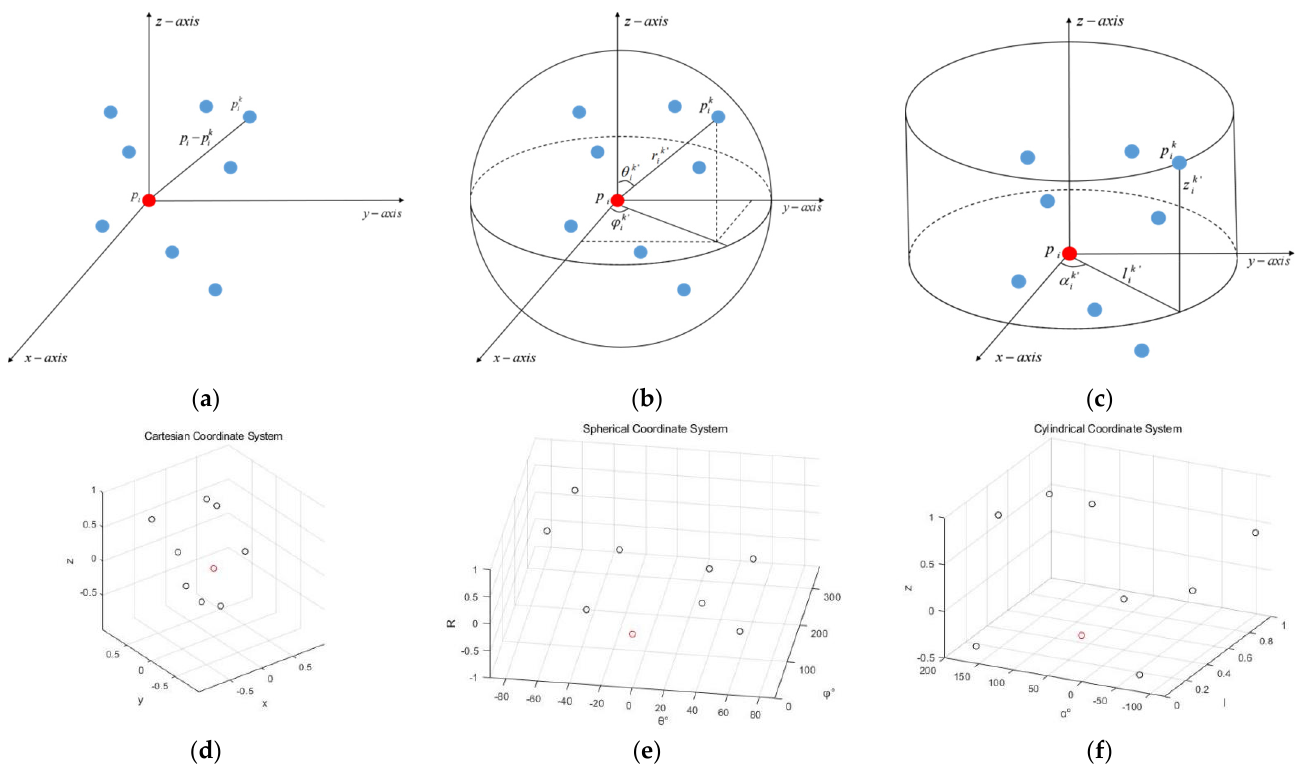
Figure 1. The conversion of spatial information. ( a ) The spatial information of cartesian coordinate systems (red: centre point. Blue: neighbouring points). ( b ) The relationship of spherical coordinate systems r k (cid:48) , θ k (cid:48) , ϕ k (cid:48) and cartesian coordinate systems. ( c ) The relationship of cylindrical coordinate systems l k (cid:48) , α k (cid:48) , z k (cid:48) and cartesian coordinate systems. ( d ) The original distribution of the centre point (red point) and its neighbouring points (black point). ( e ) The distribution of points (same as in ( d )) in the spherical coordinate system. ( f ) The distribution of points (same as in ( d )) in the cylindrical coordinate system.